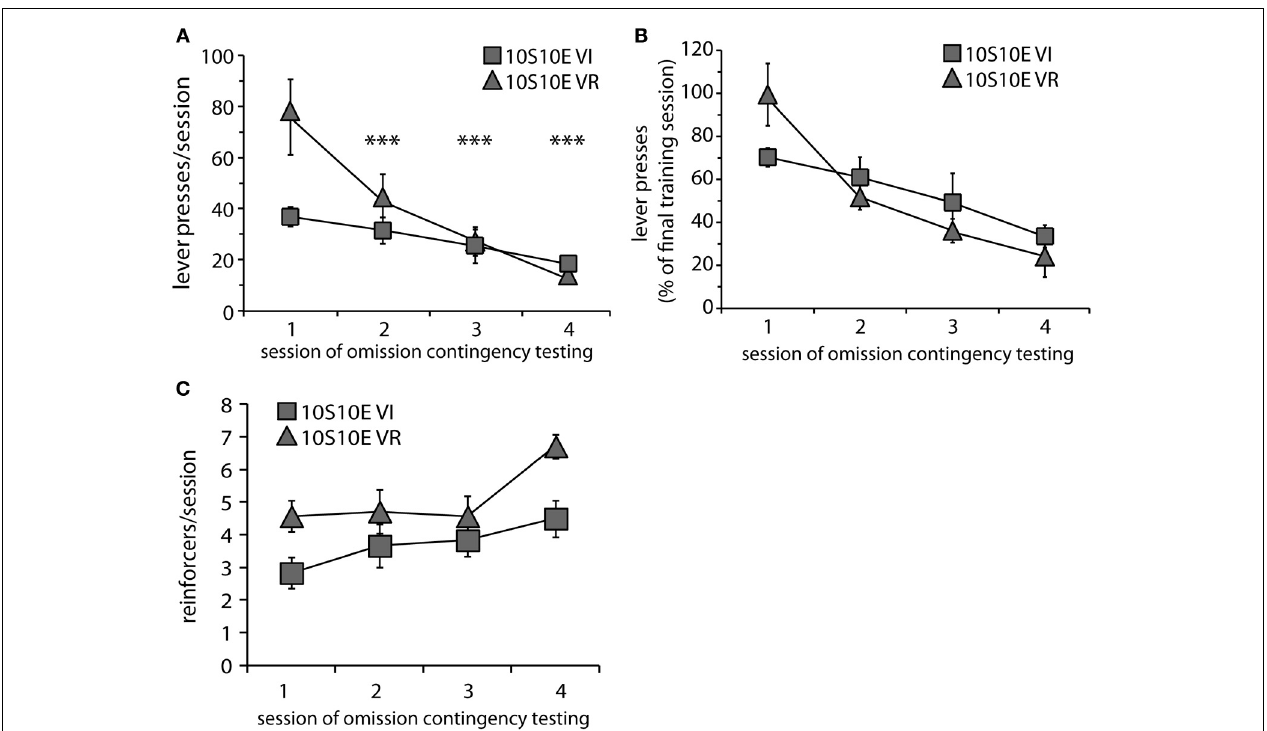
FIGURE 2 | Testing of 10S10E groups. (A) The number of lever presses per session declined across testing for the 10S10E VR (triangles), but not the 10S10E VI (squares) group. ∗∗∗ Indicates for the VR group the sessions that were significantly different from session 1 ( p < 0 . 001 level of significance for post-hoc contrasts). (B) The